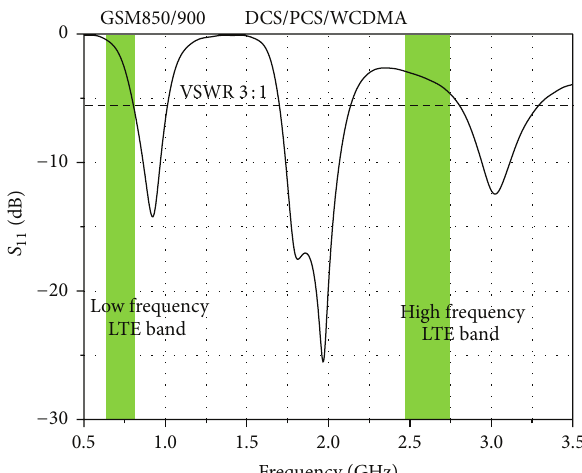
Figure 2: Simulated 𝑆 11 of the proposed penta-band PIFA.